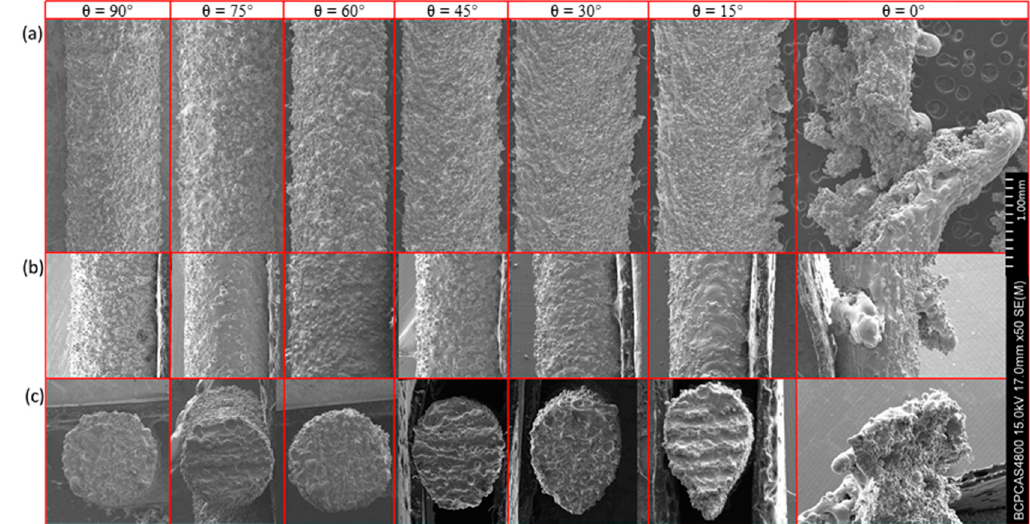
Figure 4. RA sample SEM image for design diameter of 1 mm and the inclination angles of 90–0° in 15° decrements: ( a ) taken from the horizontal direction; ( b ) taken from a vertical direction; and ( c ) taken from the cross section.